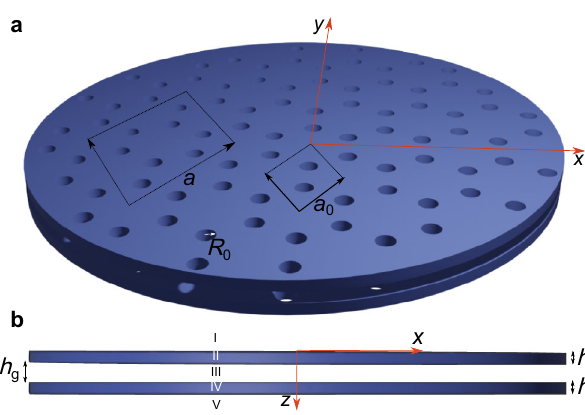
Fig. 1 The twistsonic medium. a The rigid bilayer is perforated with N round holes of radius R 0 , which are arranged in a honeycomb lattice comprising a primitive unit cells of size a 0 and the moiré super cell of size a . b The side view of the structure enables one to distinguish the individual regions used for the